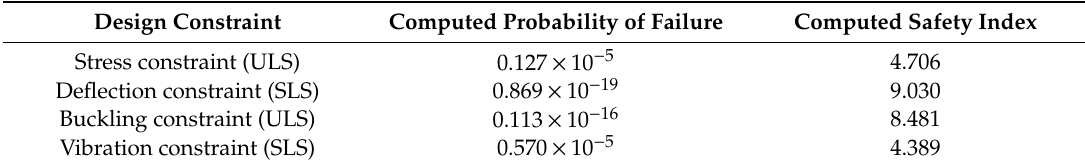
Figure 9. Reliability index of different design constraints (non-intrusive formulation). Table 10. Computed probability of failure and safety index values using first-order reliability method (FORM) for different limit states.